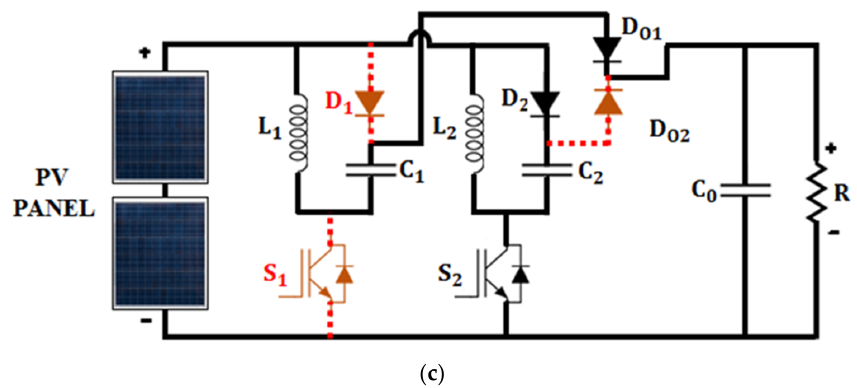
Figure 4. Operation of the Luo converter in: ( a ) Phase-1; ( b ) Phases-2 and 4; ( c ) Phase-3.